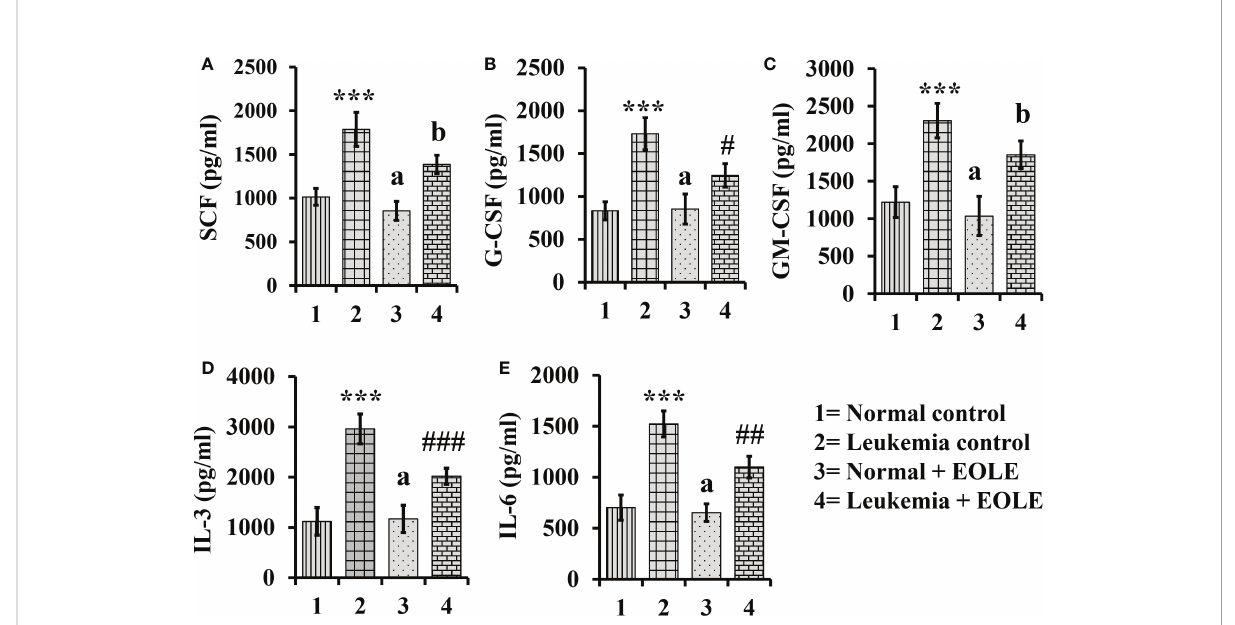
FIGURE 5 Bar diagrams showing the effect of EOLE treatment in the bone marrow concentrations of various hematopoietic cytokines, where (A) SCF, (B) G-CSF, (C) GM-CSF, (D) IL-3, (E) IL-6; values are expressed as mean ± SD of 3 different observations. The statistical signi fi cance was tested using one-way ANOVA and Tukey ’ s multiple comparison tests by comparing the values as, Group-1 vs . Group-2, 3; Group-2 vs . Group- 4. P value, p < 0.05 was considered as statistically signi fi cant. When compared with Group-1 the level of signi fi cance was denoted as, a = not signi fi cant when p > 0.05; * when p < 0.05; ** when p < 0.01; and *** when p < 0.001. When compared with Group-2, b = not signi fi cant when p >0.05; # when p < 0.05; ## when p < 0.01; and ### when p <